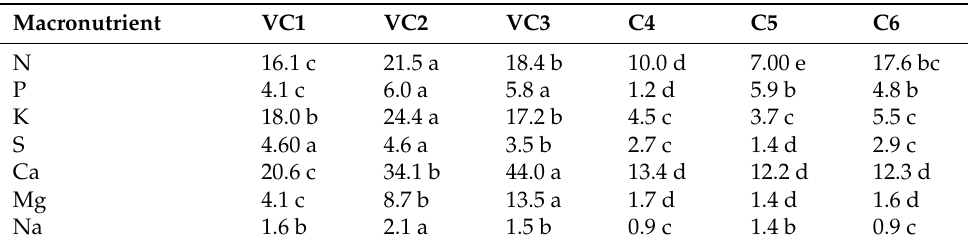
Table 3. Macronutrient total amounts in analyzed vermicomposts and composts (g · kg − 1 ). Macronutrient